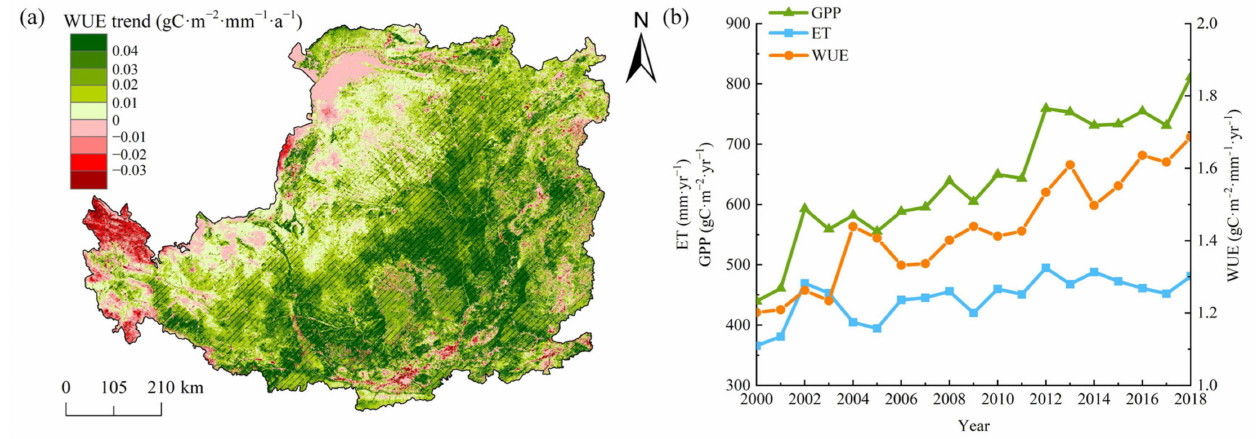
Figure 4. ( a ) Trends of the WUE and ( b ) the temporal variations in the annual GPP, ET and